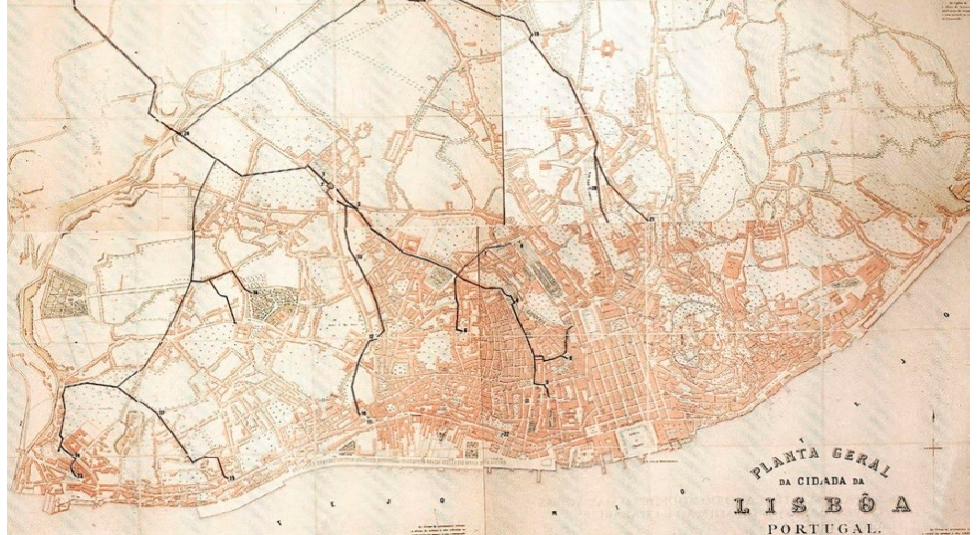
Figure 4. Historical cartography of Lisbon aqueduct, dating from 1990 (© CDHT—X-arqWeb).